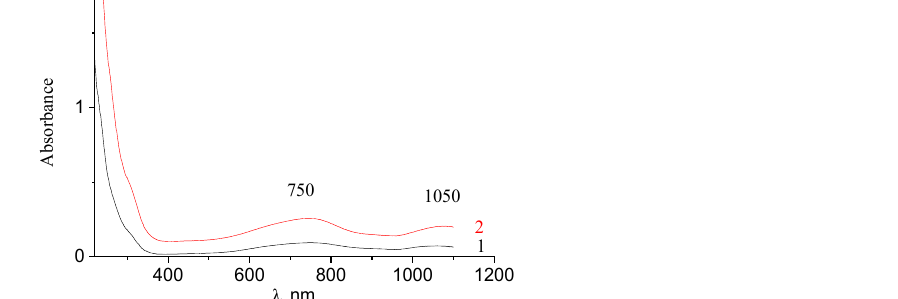
Figure 3. TG and DTA curves of molybdenum blue xerogels synthesized using glucose (black lines) and hydroquinone (red lines).